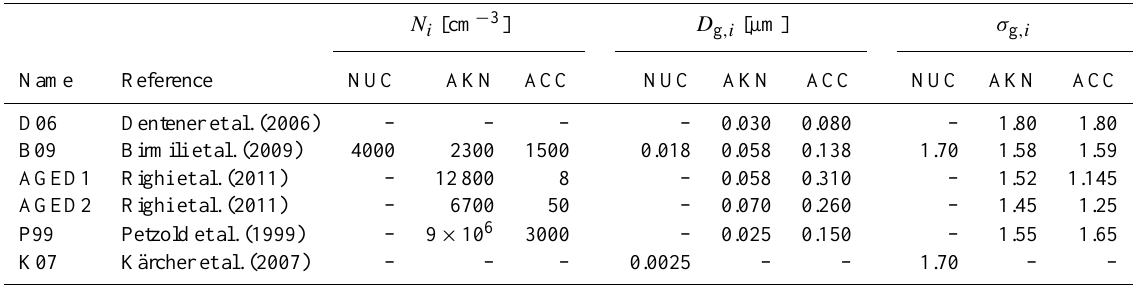
Table 1. Parameters of the size distributions considered to derive particle number emission fluxes from the mass fluxes of anthropogenic and biomass burning emissions. The nucleation, Aitken and accumulation modes are indicated by NUC, AKN and ACC, respectively. The parameters are used to assign the emitted particle mass to the different size modes and to calculate the corresponding number of emitted particles. The nucleation and Aitken modes are both assigned to the Aitken mode of MADE. N i [cm − 3 ] D g ,i [µm] σ g